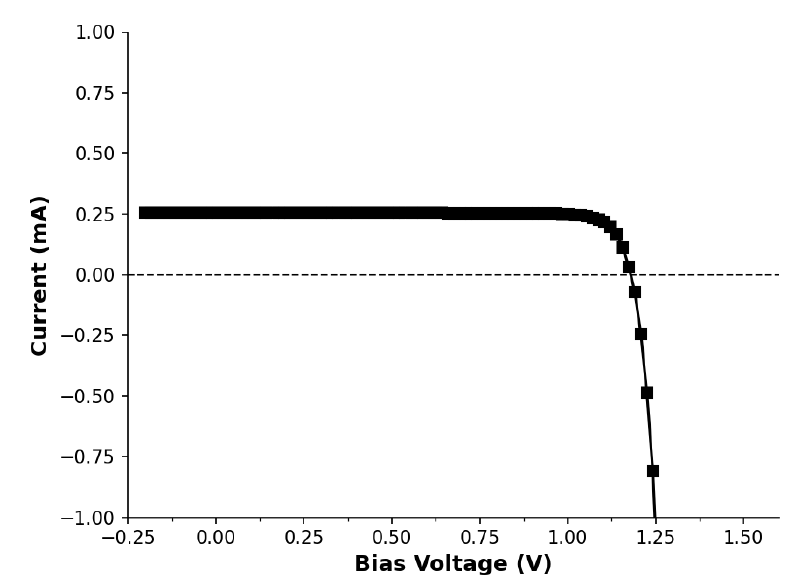
Figure A1. JV Curve of the LED measured in open circuit.